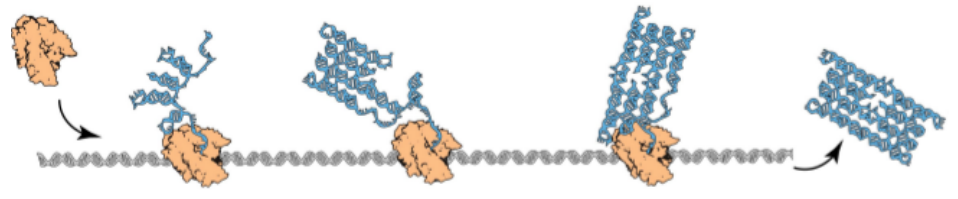
Figure 1. An RNA molecule folding over itself while being transcribed, as the experiments in [29].